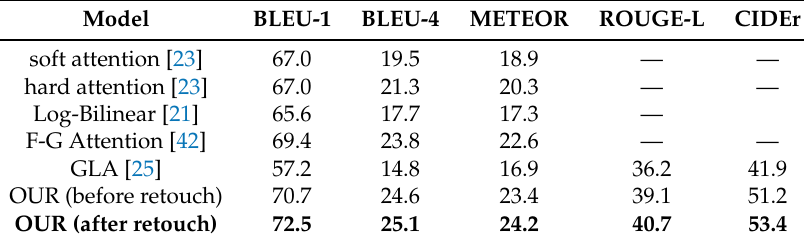
Table 7. Evaluation results of our method on the Flickr8K dataset.